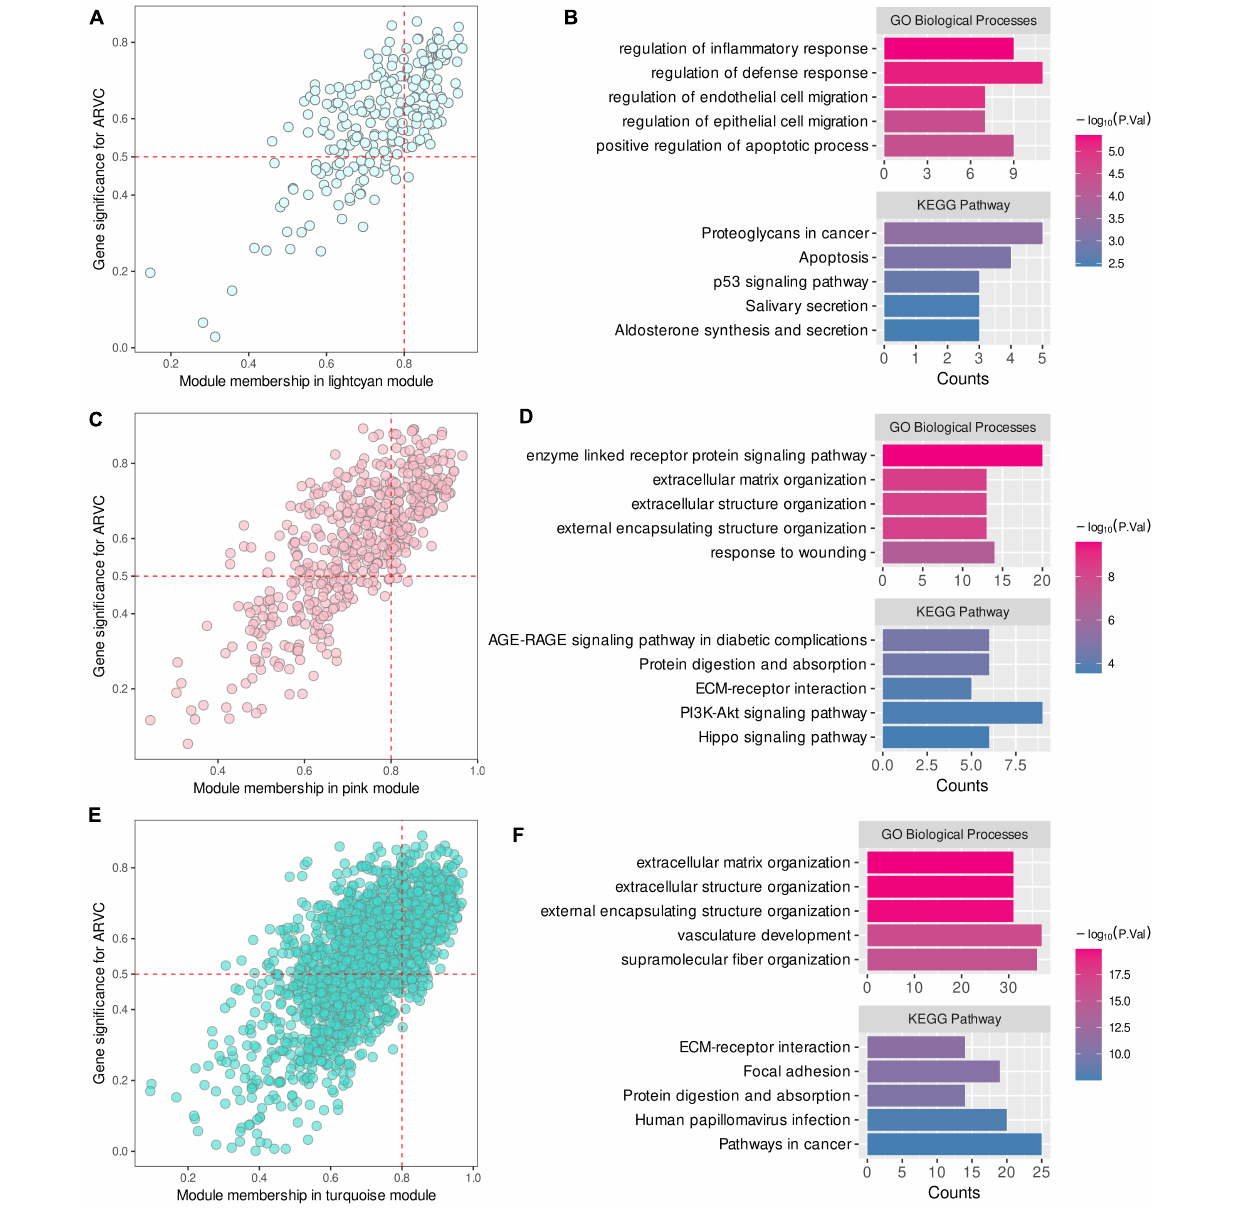
FIGURE 2 | Identification of intra-modular candidate hub genes in ARVC hub modules. (A,B) Candidate hub genes in the lightcyan module with functional enrichment results. (C,D) Candidate hub genes in the pink module with functional enrichment results. (E,F) Candidate hub genes in the turquoise module with functional enrichment